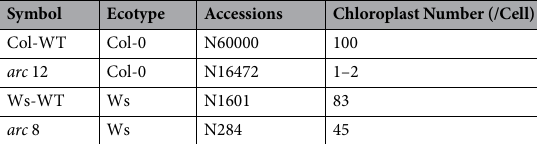
Table 1. Details of the materials used in this study. The chloroplast numbers were obtained from the European Arabidopsis Stock Centre (NASC, http://arabidopsis.info/) with the accession